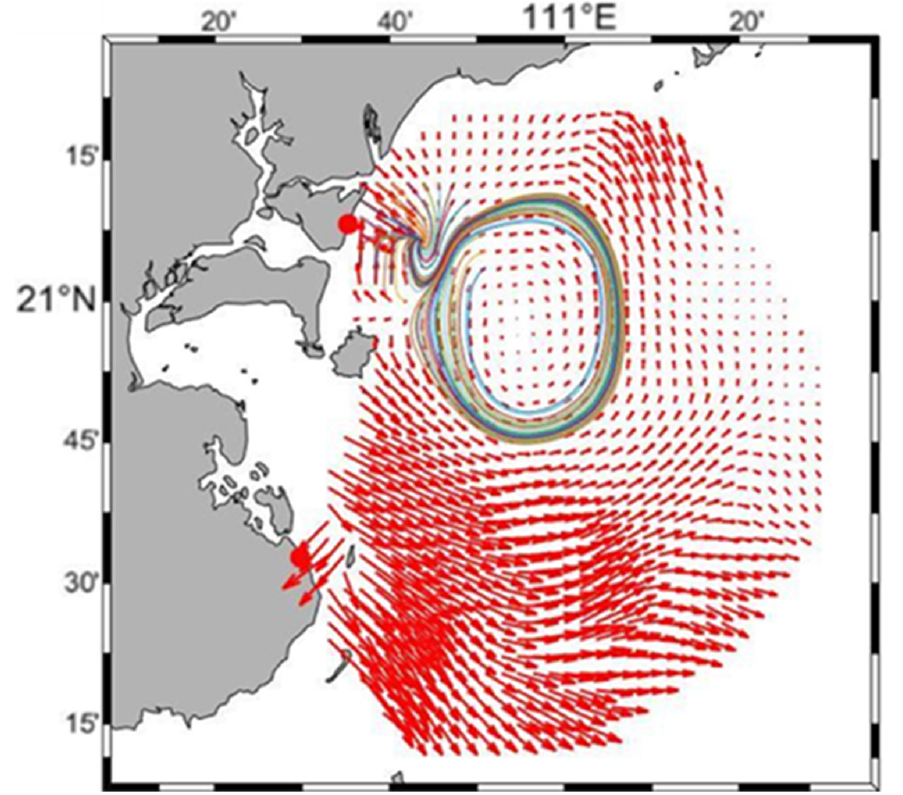
Figure 11. The case of two eddies rotating in opposite directions.